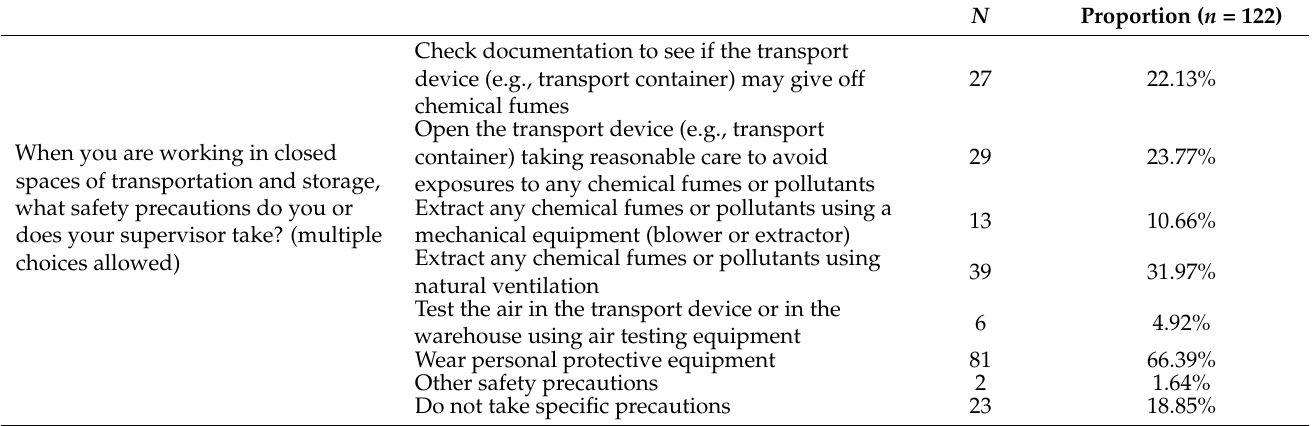
Table 7. Workplace health and safety precautions applied by warehouse workers in closed spaces of transportation and storage.